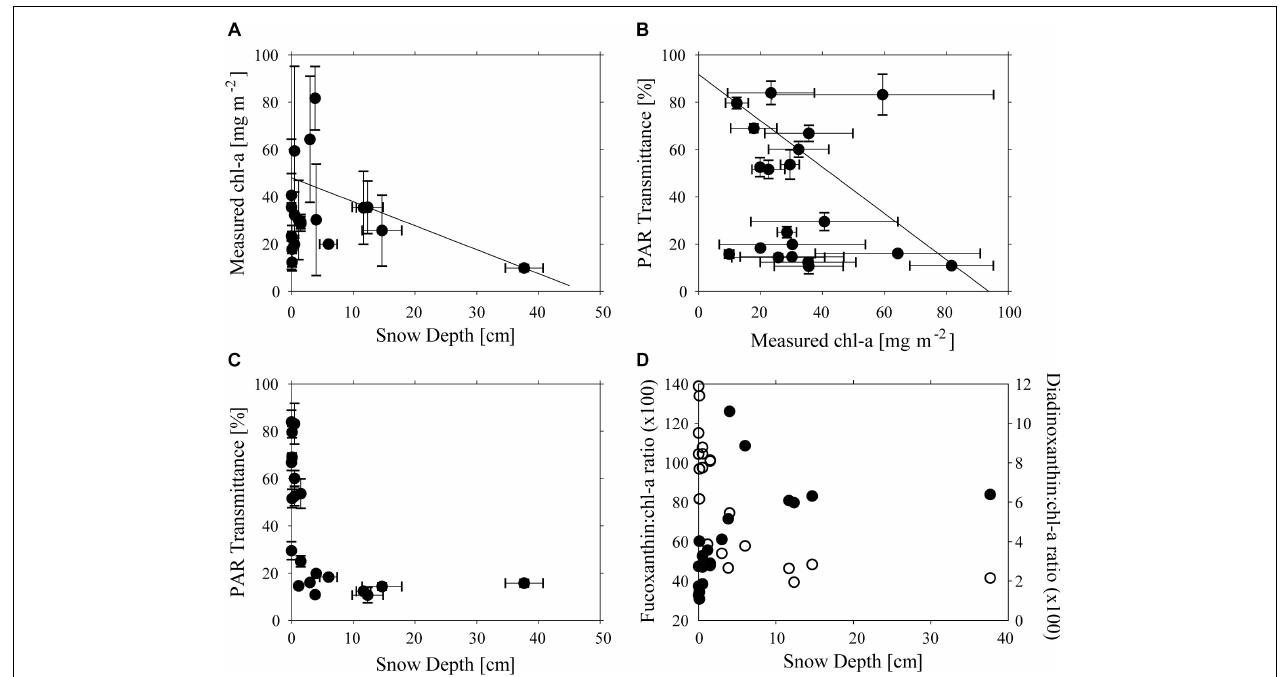
FIGURE 2 | Relationships between (A) Snow Depth (cm) and chl-a concentration (mg m − 2 ), (B) chl-a concentration (mg m − 2 ) and PAR transmittance (%), (C) Snow Depth (cm), and PAR transmission (D) Fucoxanthin:chl-a ratio and Snow Depth (cm) (filled circles) and Diadinoxanthin:chl-a ratio (unfilled circles). Lines in (A,B) show significant 80% quantile regression lines and error bars are shown in (A–C) .